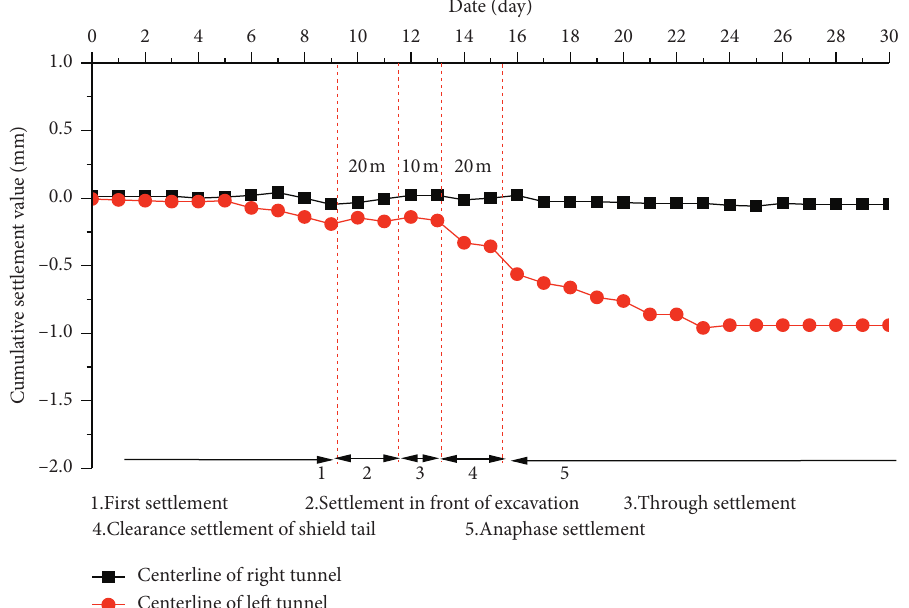
Figure 16: The settling time curve of the ground when the left-line shield passes through (grouting reinforcement).